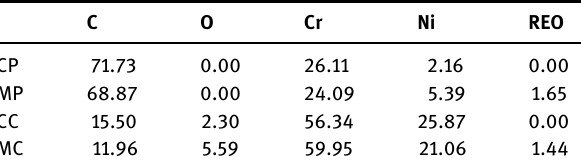
Table 3: Elemental composition of Cr 3 C 2 – NiCr powders and coat - ings ( wt%